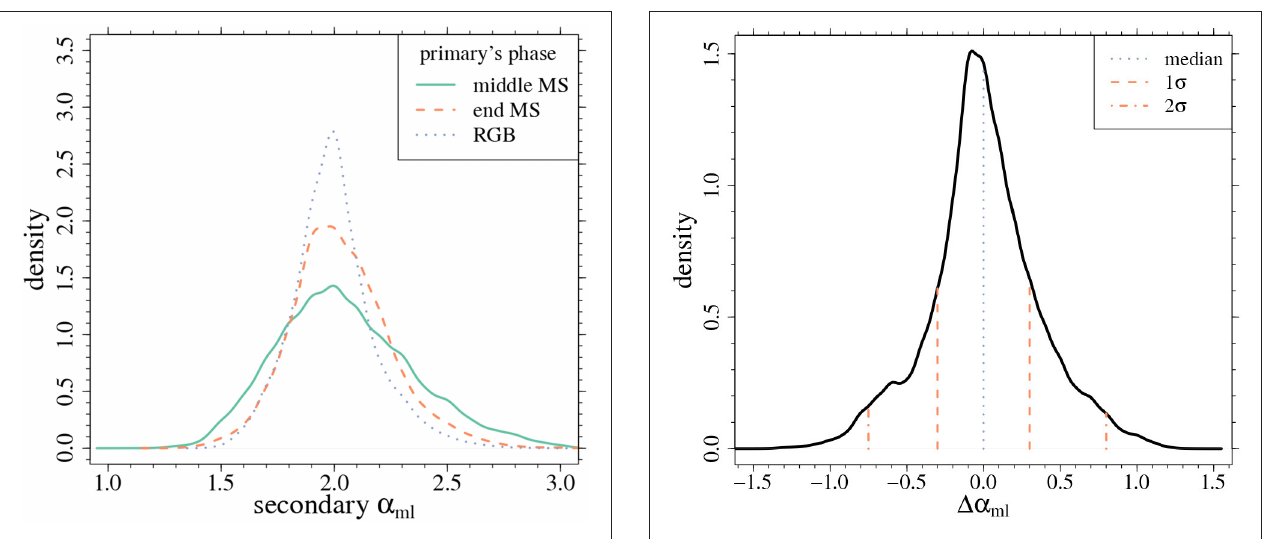
FIGURE 4 | Density of probability of mixing-length value estimates for the secondary star for synthetic data with α ml = 2.0, as a function of the evolutionary phase of the primary star.